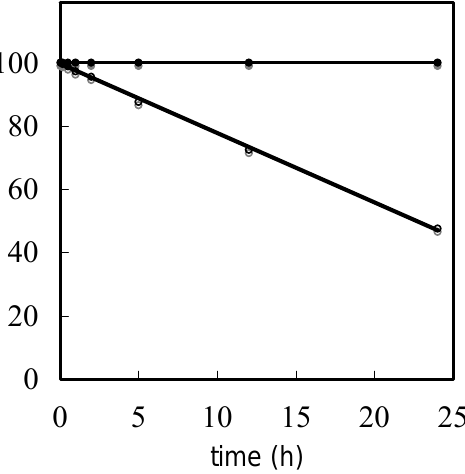
Figure 2. The remaining amount (%) of T or T Bz in its reaction with acrylonitrile. Open and filled circles refer to the remaining amounts (%) of T and T Bz in use of T and T Bz , respectively. Conditions: 100 equiv of acrylonitrile in DBU/CH